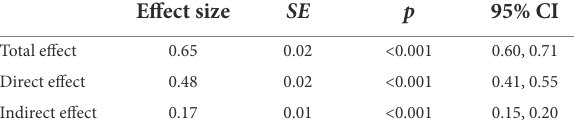
TABLE 3 Path analysis